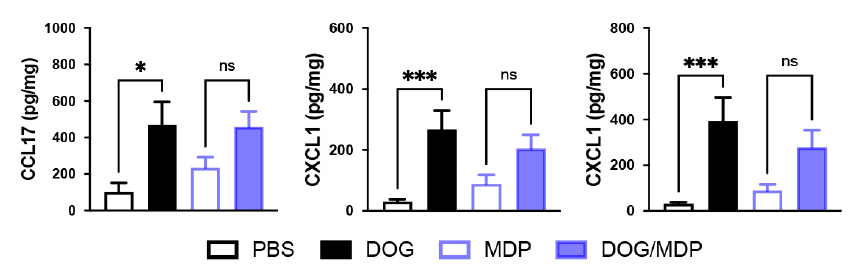
Figure 4. NOD2 ligand co-stimulation does not modify allergen-induced lung chemokine production. Protein levels of CCL17, CXCL1, and CXCL2. Chemokines were assessed by ELISA in lung tissues from control and challenged mice. Data are presented as mean ± SEM (n = 4–18 mice per group). * p < 0.05, *** p < 0.001 versus PBS, ns: not significant. Kruskal–Wallis test for all.